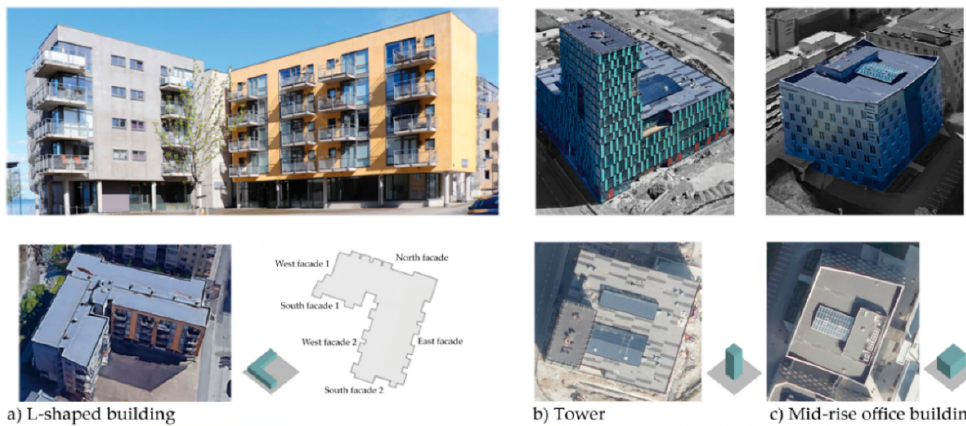
Figure 6. Examples of the most common types of building typologies in Trondheim. Table 7. Criteria for choosing buildings for reduction factor analysis. Importance